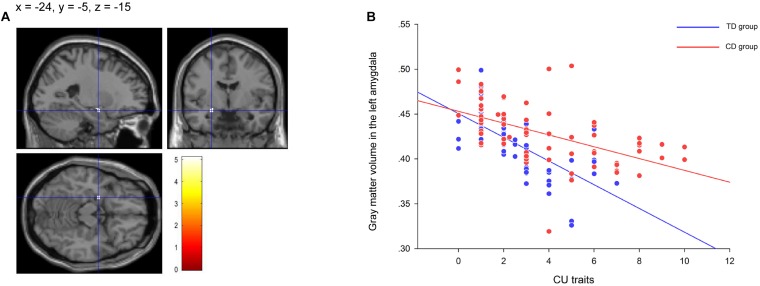
The significant correlation between gray matter volume in the left amygdala and callous-unemotional (CU) traits in the conduct disorder (CD) group and the typically developing (TD) group. The negative correlation between CU traits and gray matter volumes in the left amygdala (−24, −5, −15) (A) showing in the residual plot (B) within the CD participants and within the TD participants after controlling for total intracranial volume, age, IQ, conduct problem scores and age-of-onset. The color bar represents t statistics. The image is thresholded at P < 0.05, whole-brain voxel-level family wise error correction. CD = Conduct Disorder; TD = Typically Developing.